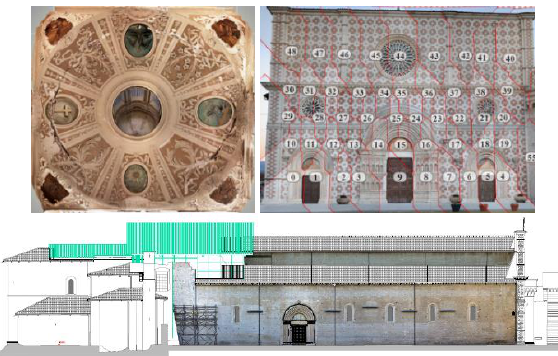
Figure 4. Orthophotos of vaults and facades are fundamental not